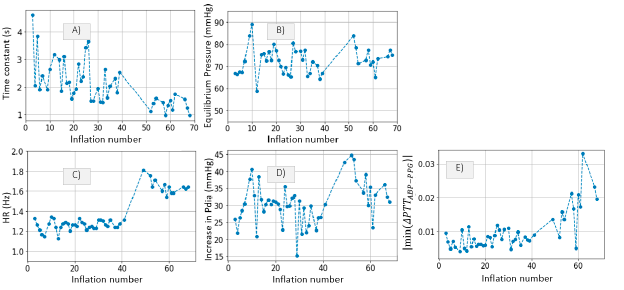
Figure 19. ( A ) Time constant τ and ( B ) P Equilibrium from Patient 2 data. ( C ) HR, ( D ) increase in P dia and ( E ) maximum drop in ∆ PTT ABP − PPG are plotted for qualitative